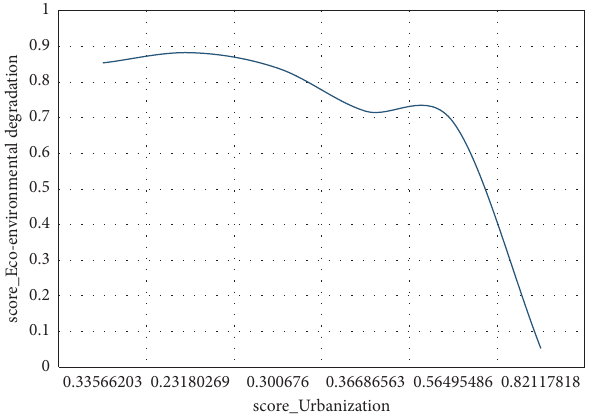
Figure 6: Curve between urbanization and ecological environment deterioration of Guizhou in